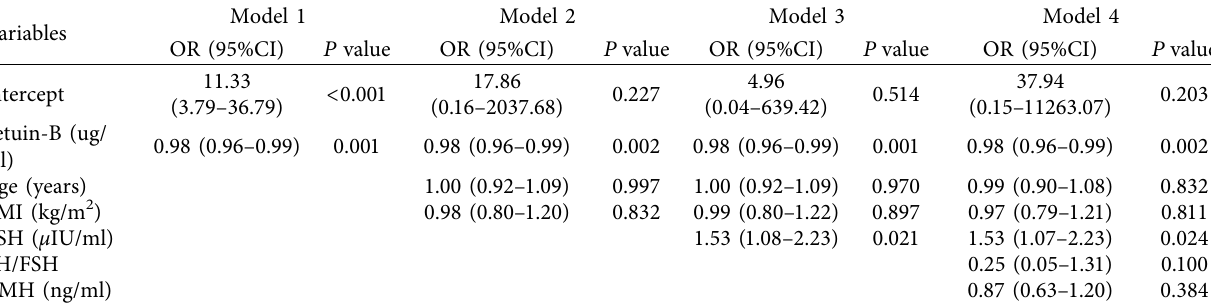
Table 2: The relationship between fetuin-B and thyroid antibodies